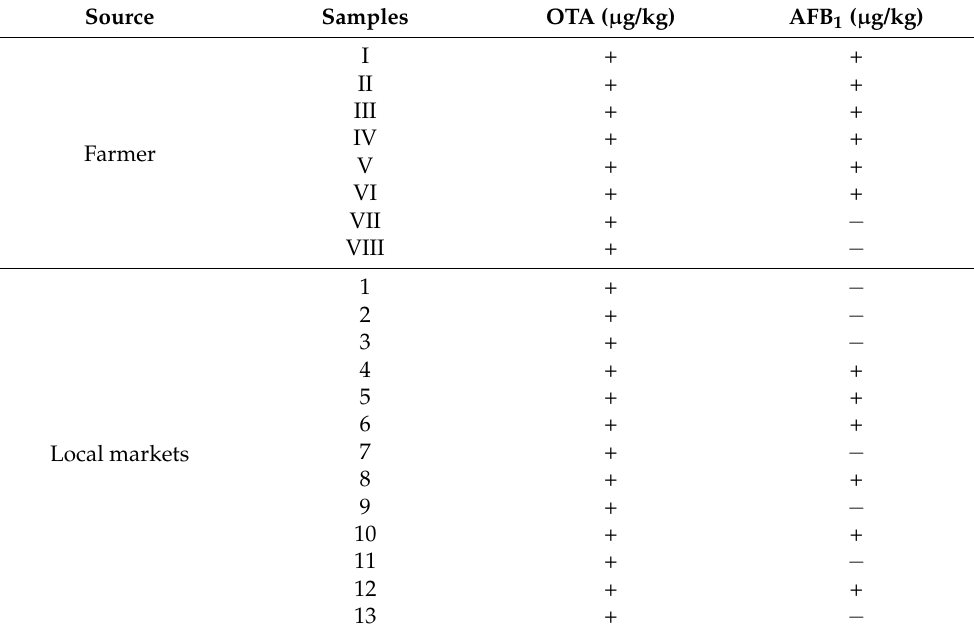
Table 2. AFs and OTA results for Merk é n from farmers ( n = 8) and markets ( n = 13) of the region of La Araucan í a,